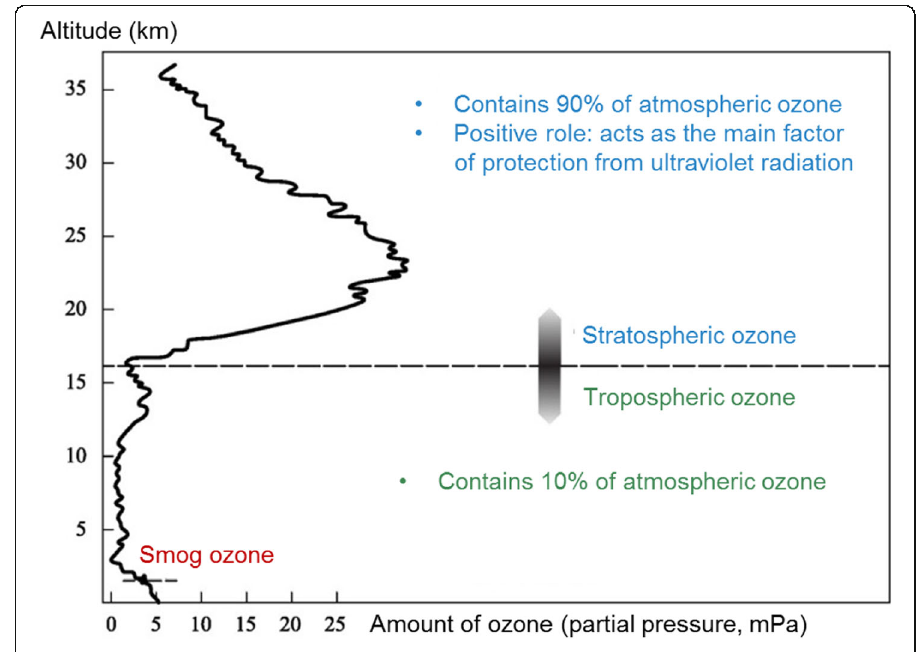
Fig. 12 The dependency of ozone partial pressure on